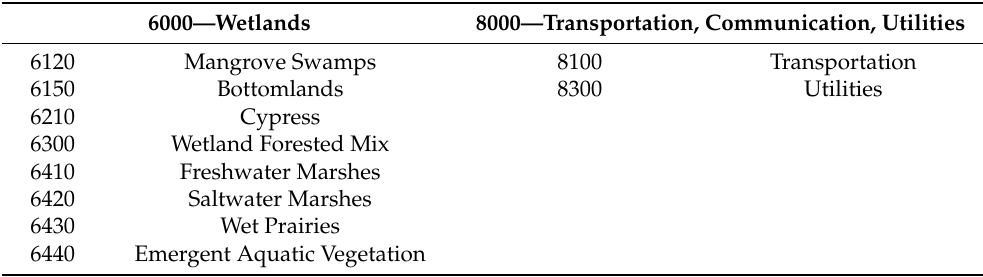
Table 3. Initial SWFWMD Level II FLUCCS sub-classes for the “Wetlands” and “Transportation, Communication, and Utilities”